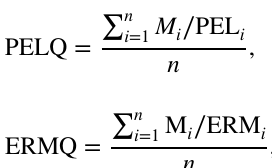
geo ) of heavy metals for sediment